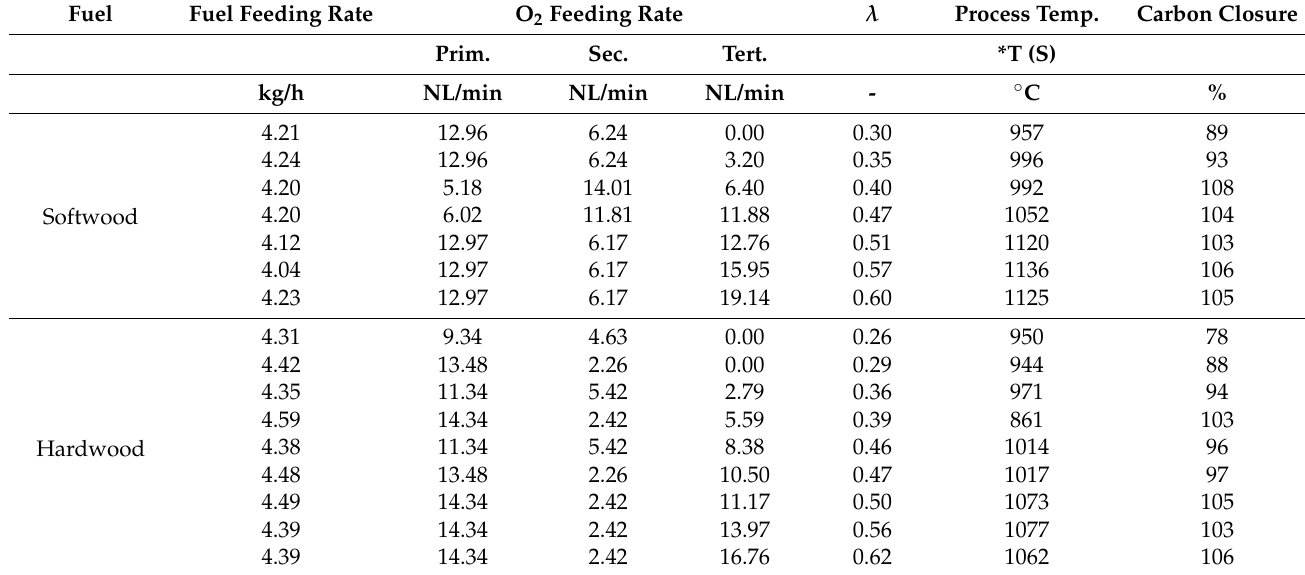
Table 2. Operating conditions, measured process temperature, and resulting carbon closure of the experiments. Fuel Fuel Feeding Rate O 2 Feeding Rate λ Process Temp. Carbon Closure Prim. Sec. Tert. *T (S) kg/h NL/min NL/min NL/min - ◦ C %